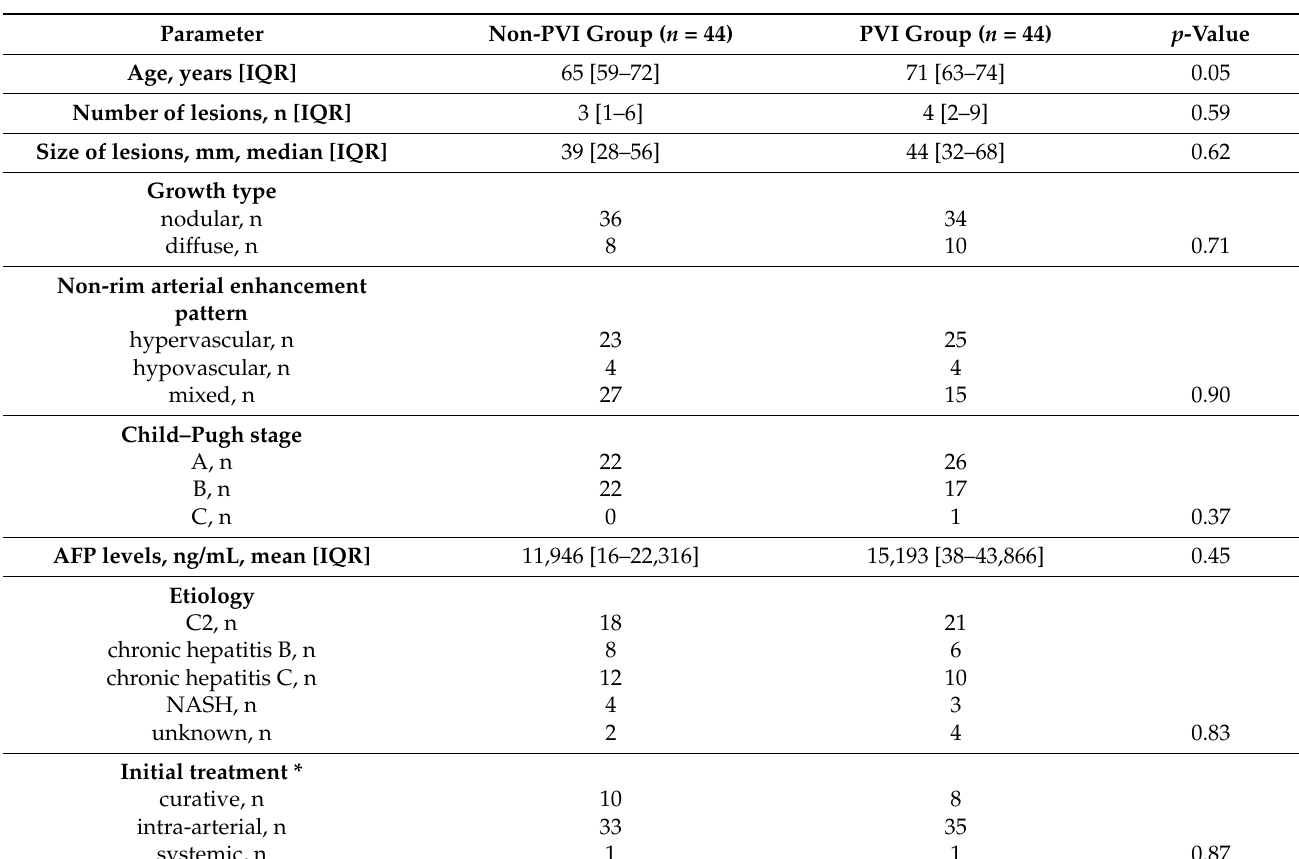
Table 1. Baseline characteristics of the patient groups without and with future PVI [IQR